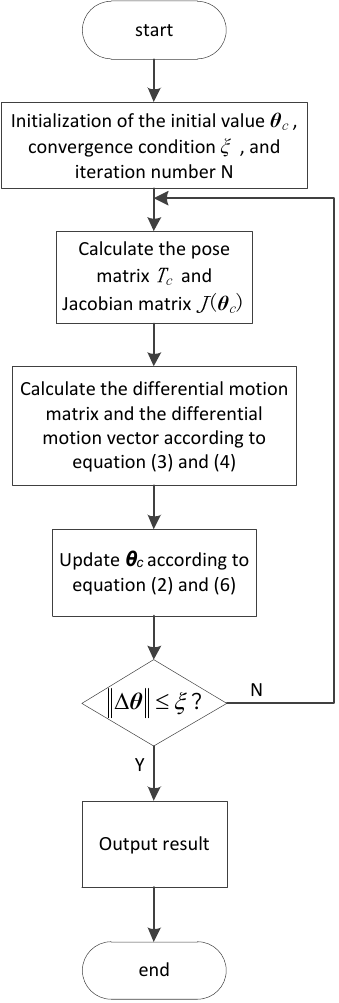
Figure 4. The Inverse kinematics iterative algorithm flowchart.